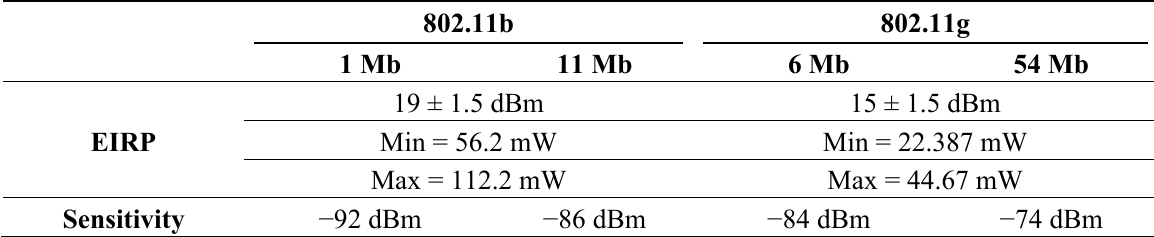
Table 9. Summary of Linksys WRT160NL datasheet.